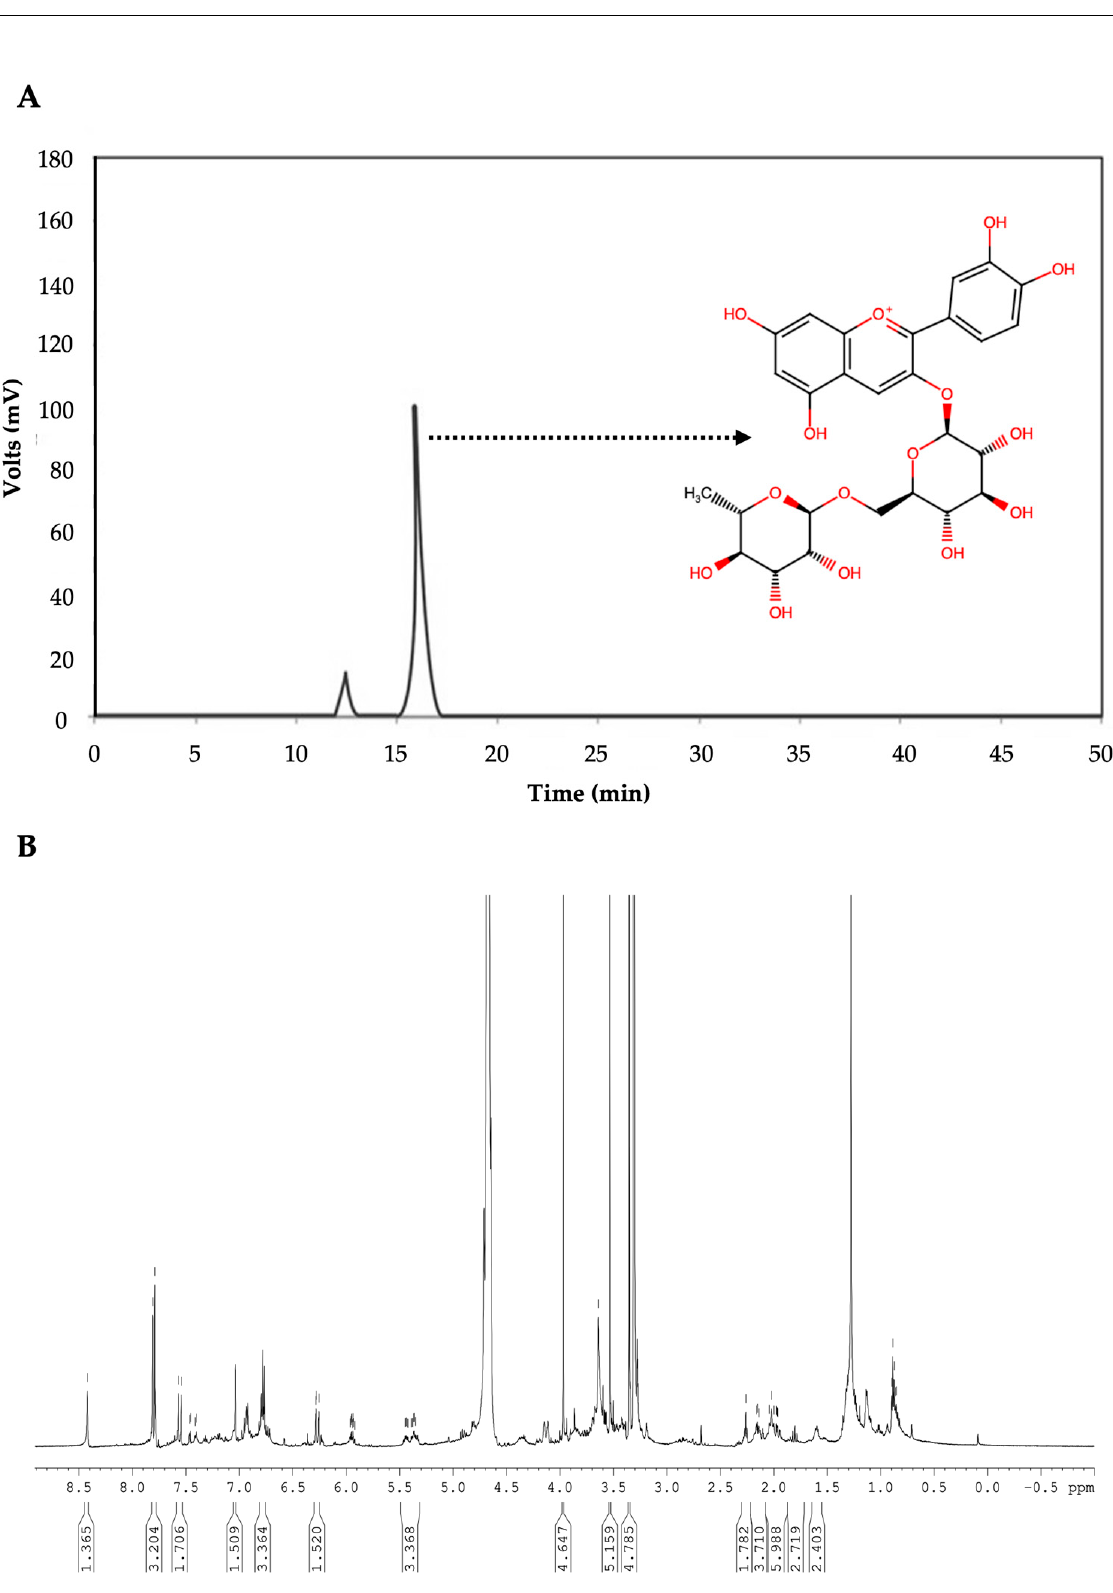
Figure 2. ( A ) HPLC profile of coffee ( Coffea arabica L.) husk extracts. The two peaks in the HPLC profile correspond to cyanidin 3-glucoside (13.8 min) and cyanidin 3-rutinoside (15.8 min). ( B ) The H 1 spectrum of the fraction obtained from the chromatographic separation of cyanidin 3-rutinoside. Refer to the text for the explanation.